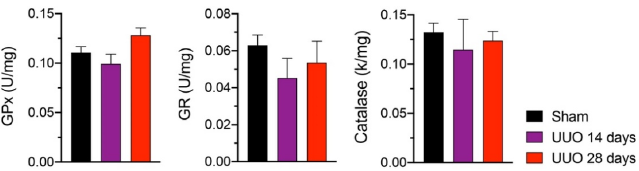
Figure 6. Antioxidant enzyme activity in isolated cardiac mitochondria from rats with unilateral ureteral obstruction (UUO) for 14 and 28 days. Data represent mean ± SEM of 4–5 independent experiments. GPx: glutathione peroxidase; GR: glutathione reductase.